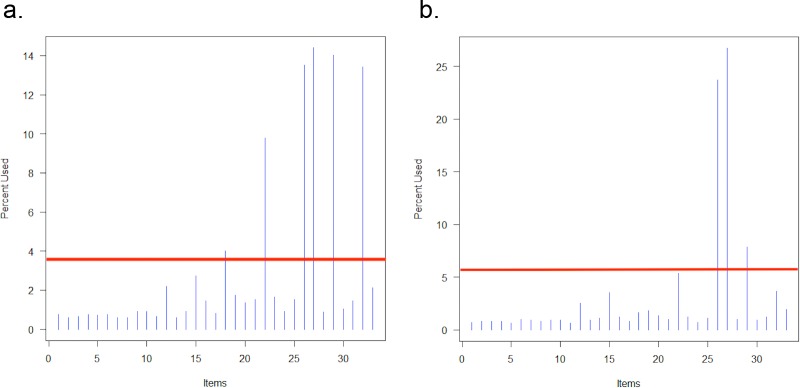
Histogram of item usage for adaptive simulation with standard error of measurement ≤0.3 (a) and ≤0.4 (b).